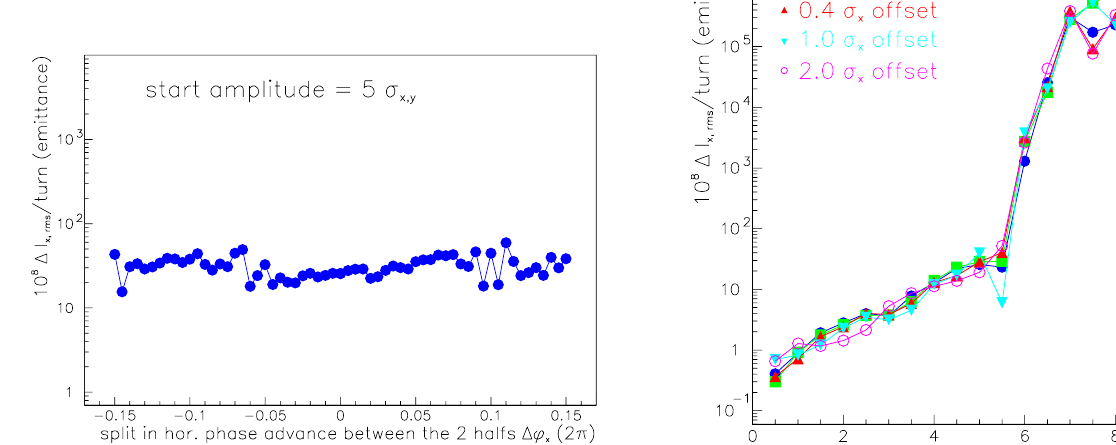
FIG. 12. (Color) The change of action variance per turn (in units of rms emittance times 10 2 8 ) as a function of the difference in horizontal phase advance between the two half arcs. The total horizontal tune is held constant, equal to the nominal. The vertical phase advance per arc is not changed.